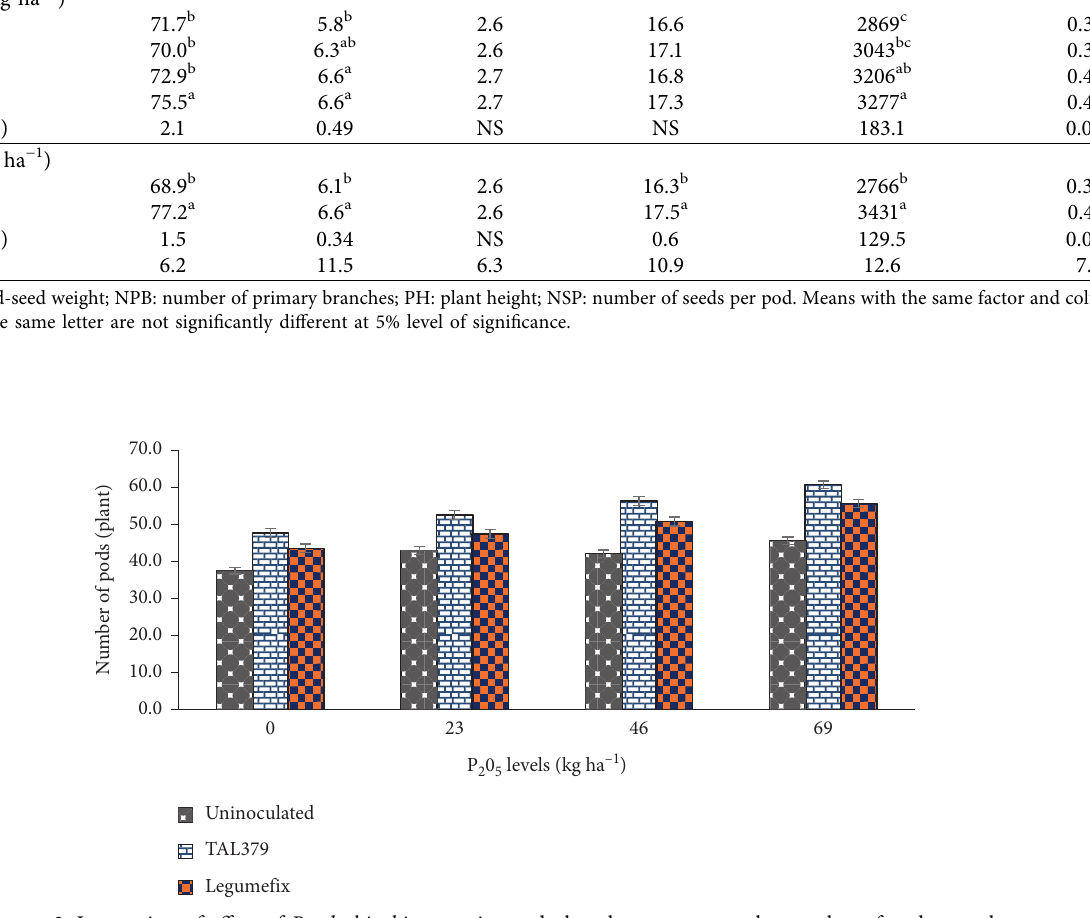
Figure 3: Interaction of effect of Bradyrhizobium strains and phosphorus rates on the number of pods per plant.